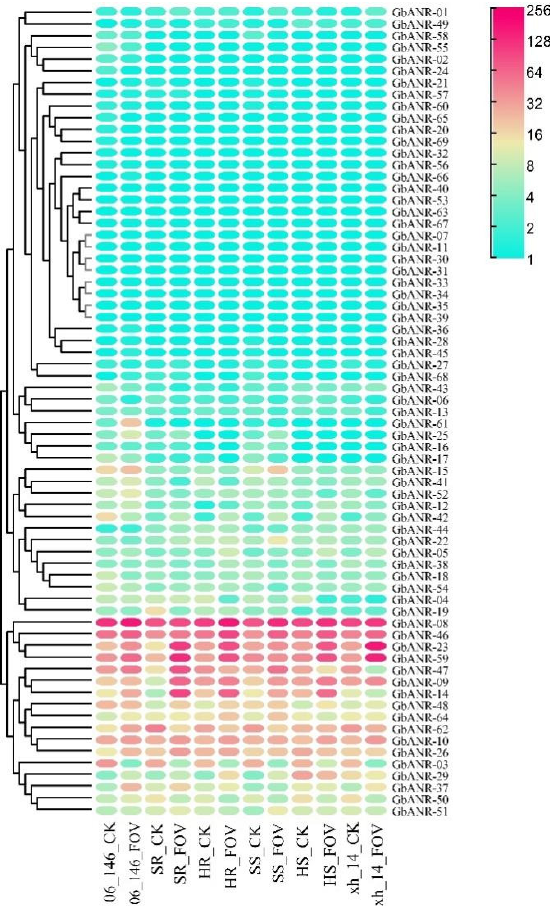
Figure 5. Expression analysis of the ANR genes in G. barbadense . The expression level was transformed by log10 (TPM+1). SR (resistant), HR (highly resistant), SS (susceptible), HS (highly susceptible).